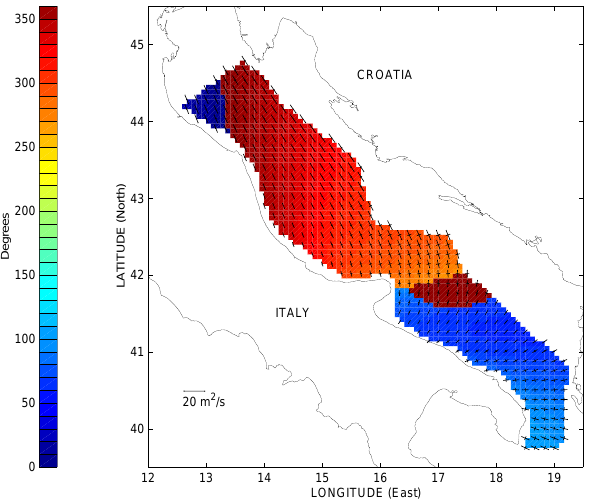
Fig. 7. Same as Fig. 6, but for the K1 tidal